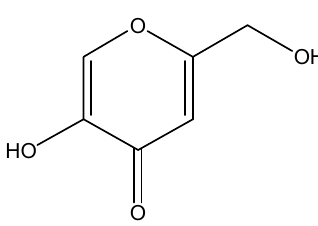
Figure 1. Structure of kojic acid